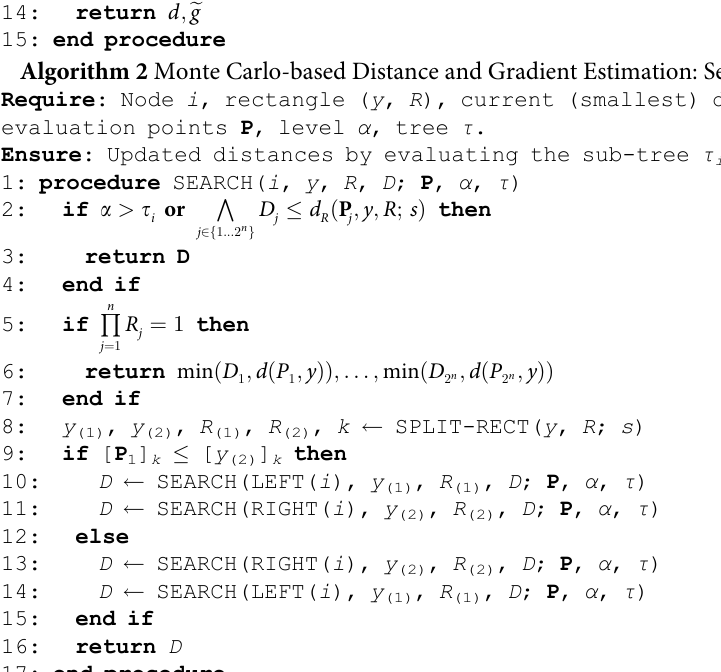
Algorithm 2 Monte Carlo-based Distance and Gradient Estimation: Search Procedure